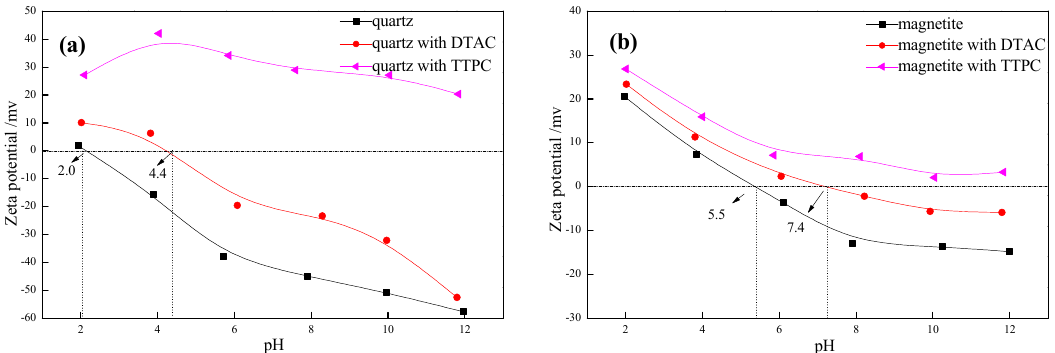
Figure 6. Effect of the addition of different reagents on the zeta potentials of quartz ( a ) and magnetite ( b ). The concentration of DTAC or TTPC is 2.0 × 10 − 5 mol/L.